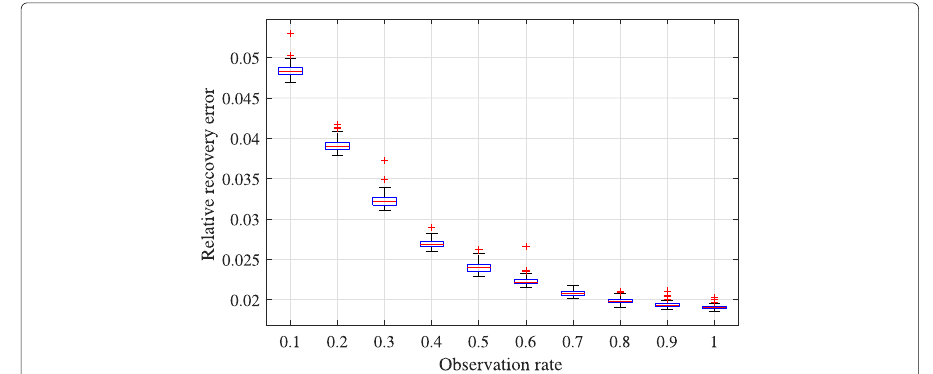
Fig. 6 Relative recovery error when the observation rate changes ( W = 3,